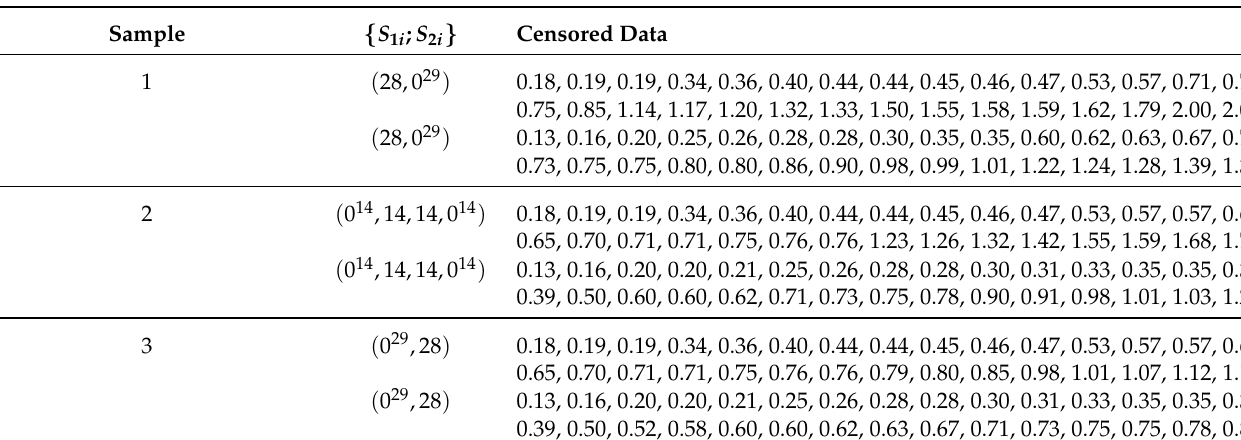
Table 8. Various PC-T-II samples from LED data.